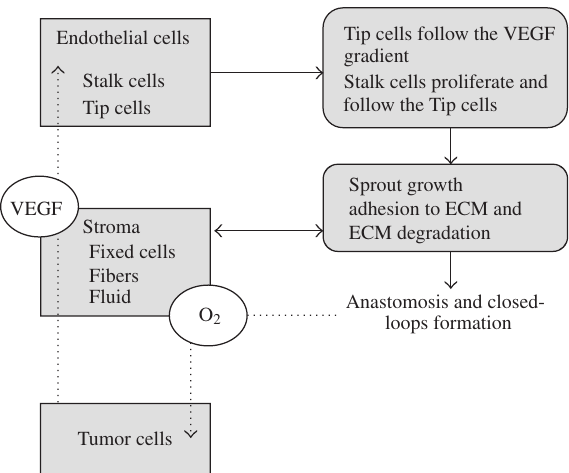
FIGURE 4: Schematic summary of cell-based simulations of tumor angiogenesis (see [65, 66]). Tumor cells secrete VEGF that stimulates EC, and the model distinguishes between tip and stalk EC phenotypes. The tip cells respond by moving chemotactically towards higher concentrations of VEGF using the matrix fibers for support. They are also capable of degrading the ECM. VEGF-stimulated stalk cells can proliferate and/or move behind a tip cell. Thus, vessels emerge that follow the chemotactic path of the endothelial tip cells. As anastomoses occur, a network of vessels is formed. In the model by Mahoney et al. [66], oxygen is also secreted from the endothelial cells that belong to closed loops. It diffuses through the medium and reaches the tumor, where it is consumed by the tumor cells. Cellular dynamics (grey boxes and solid line arrows) are modeled by using CPM, the VEGF, and O 2 profiles by continuous models based on the diffusion equation (white boxes and dashed line